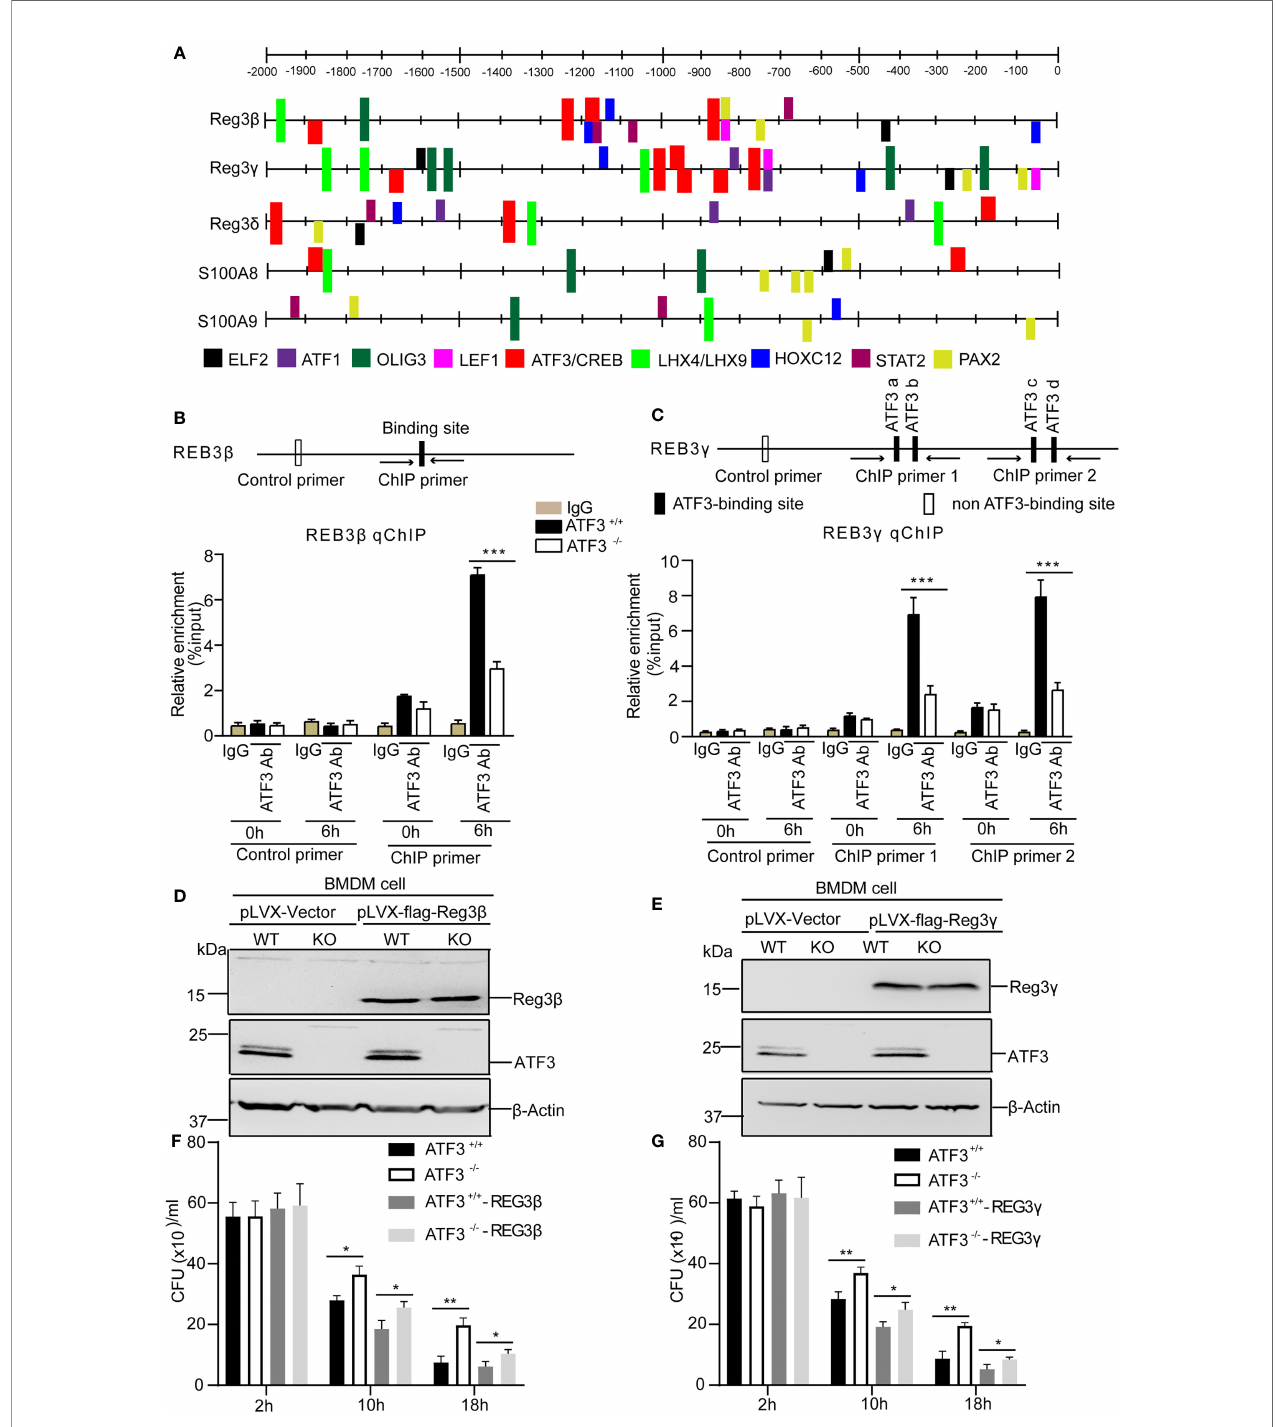
FIGURE 6 | ATF3 directly regulates the antimicrobial genes through the ATF3-binding sites. (A) Schematic linear map shows the putative binding sites of ATF3 and other transcription factors of the AMP genes. (B, C) The diagram shows the regulatory regions of the AMP gene that contain or lack the high-af fi nity ATF3-binding site (black and white boxes on the map). ChIP assays was performed in WT and ATF3 KO cells using either anti-IgG or an anti-ATF3 antibody to assess binding ability at the putative ATF3 binding site in Reg3 b and Reg3 g promoter pretreated with PBS or S. aureus. (D, E) The ef fi ciency of WT and ATF3 KO BMDM cells stably over-expressing REG3 b or REG3 g was assessed by immunoblotting. (F, G) WT and ATF3 KO BMDM cells and cells stably over-expressing REG3 b or REG3 g were infected with S. aureus (MOI = 1) for the indicated time periods and then the bacterial load was measured and calculated in BMDM cells after infection. ns, P > 0.05, * P < 0.05, ** P < 0.01, ***p <